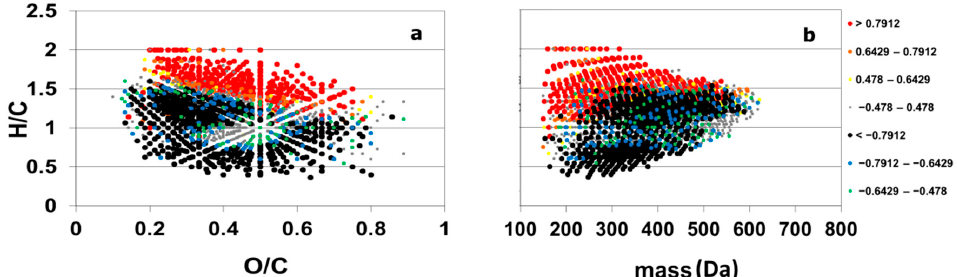
Figure 6. Van Krevelen diagrams ( a ) and mass-edited H / C ratios ( b ) of median slope values (triplicates of filter level 0.2 µ m) over the cumulated global radiation. Only the CHO-components were selected, which were found in all 77 samples. The color and dots size are related to di ff erent ranges of slope values. In the legend, the Spearman’s rank correlation coe ffi cient r s ( +/ − ) is plotted of three uncertainties ( p < 0.001; p < 0.01 and p <